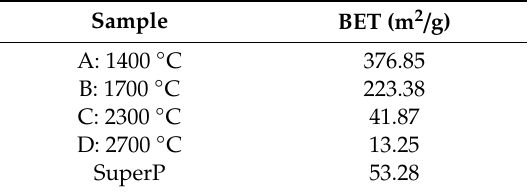
Figure 3. Nitrogen adsorption-desorption isotherms of annealed soot and SuperP. Table 4. Results of N 2 adsorption/desorption analysis.